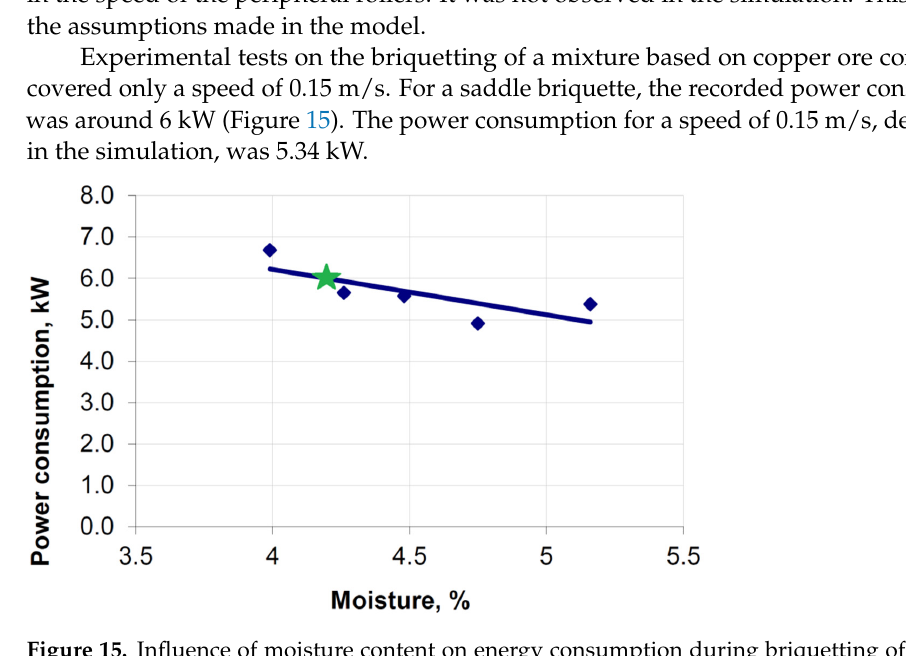
Figure 15. Influence of moisture content on energy consumption during briquetting of a mixture based on copper ore concentrate at peripheral speed of rollers v = 0.15 m/s [55]: the green star is moisture is 4.2%. moisture is